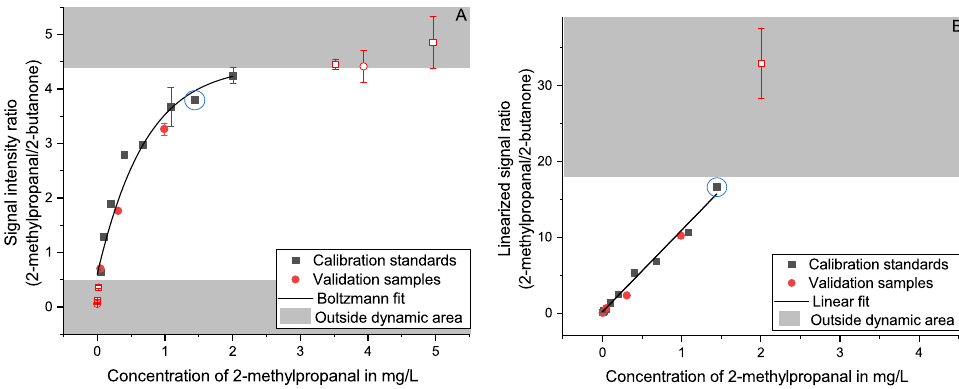
Figure 7. Calibration regression for 2-methylpropanal using 0.1 mg/L 2-butanone as an internal standard in matrix; based on a Boltzmann function ( A ) and a linearly converted function ( B ), showing the usable dynamic range of both regressions. The upper limit of the linearization (1.44 mg/L) is marked with a blue circle in both plots to clarify the different usable dynamic ranges. The area outside the usable dynamic range is colored gray, and the data points are colored light red and are unfilled to illustrate that they are not included in the calculated regression.